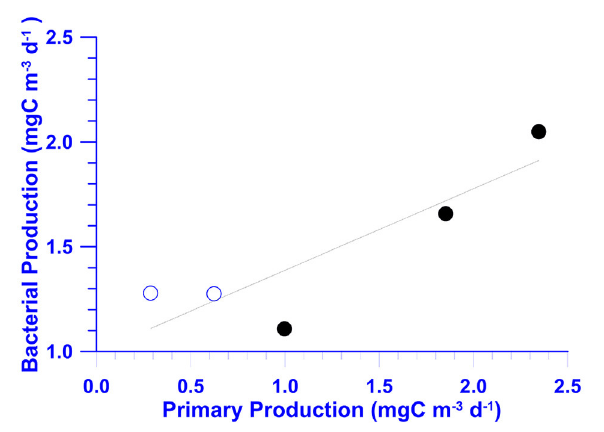
FIGURE 10 | A scatter plot of the euphotic zone (0–100m) depth-integrated averages of BP vs. PP at stations 2 (solid dots) and 6 (open dots) of the July cruise. The linear regression equation is shown.